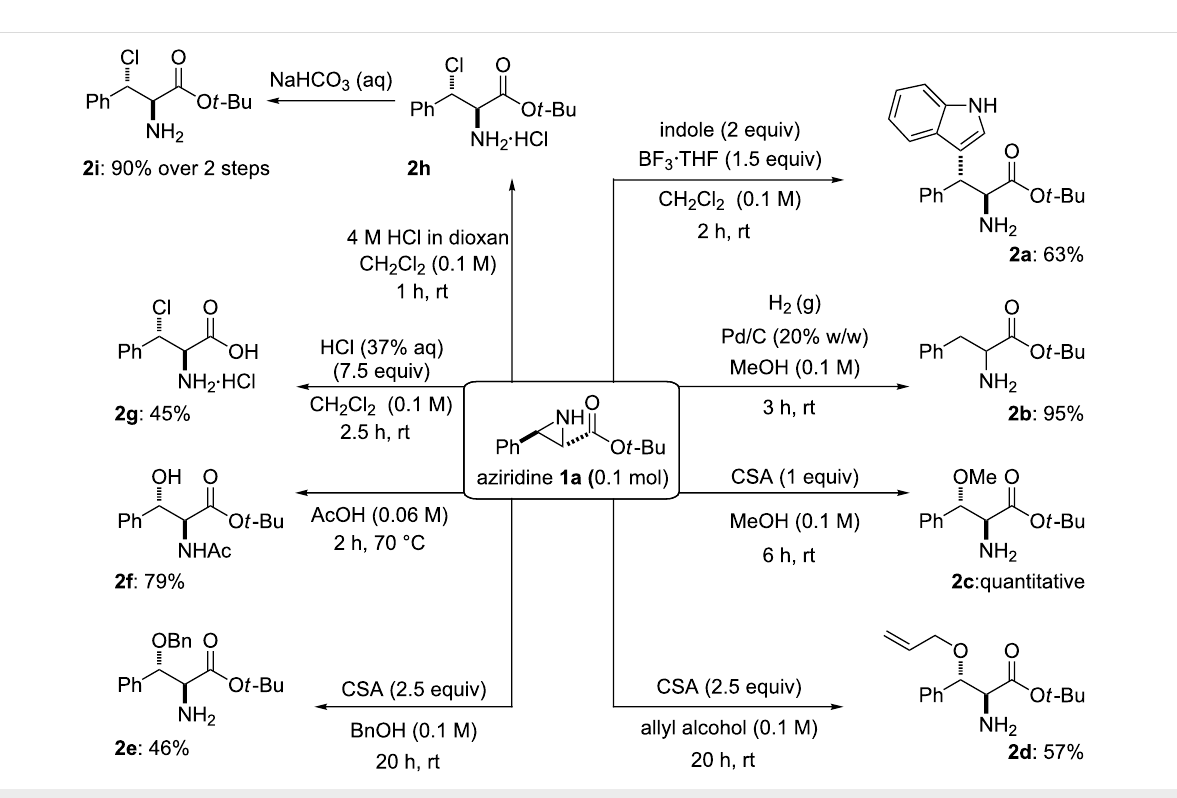
Figure 2: Ring-opened products of aziridine 1a